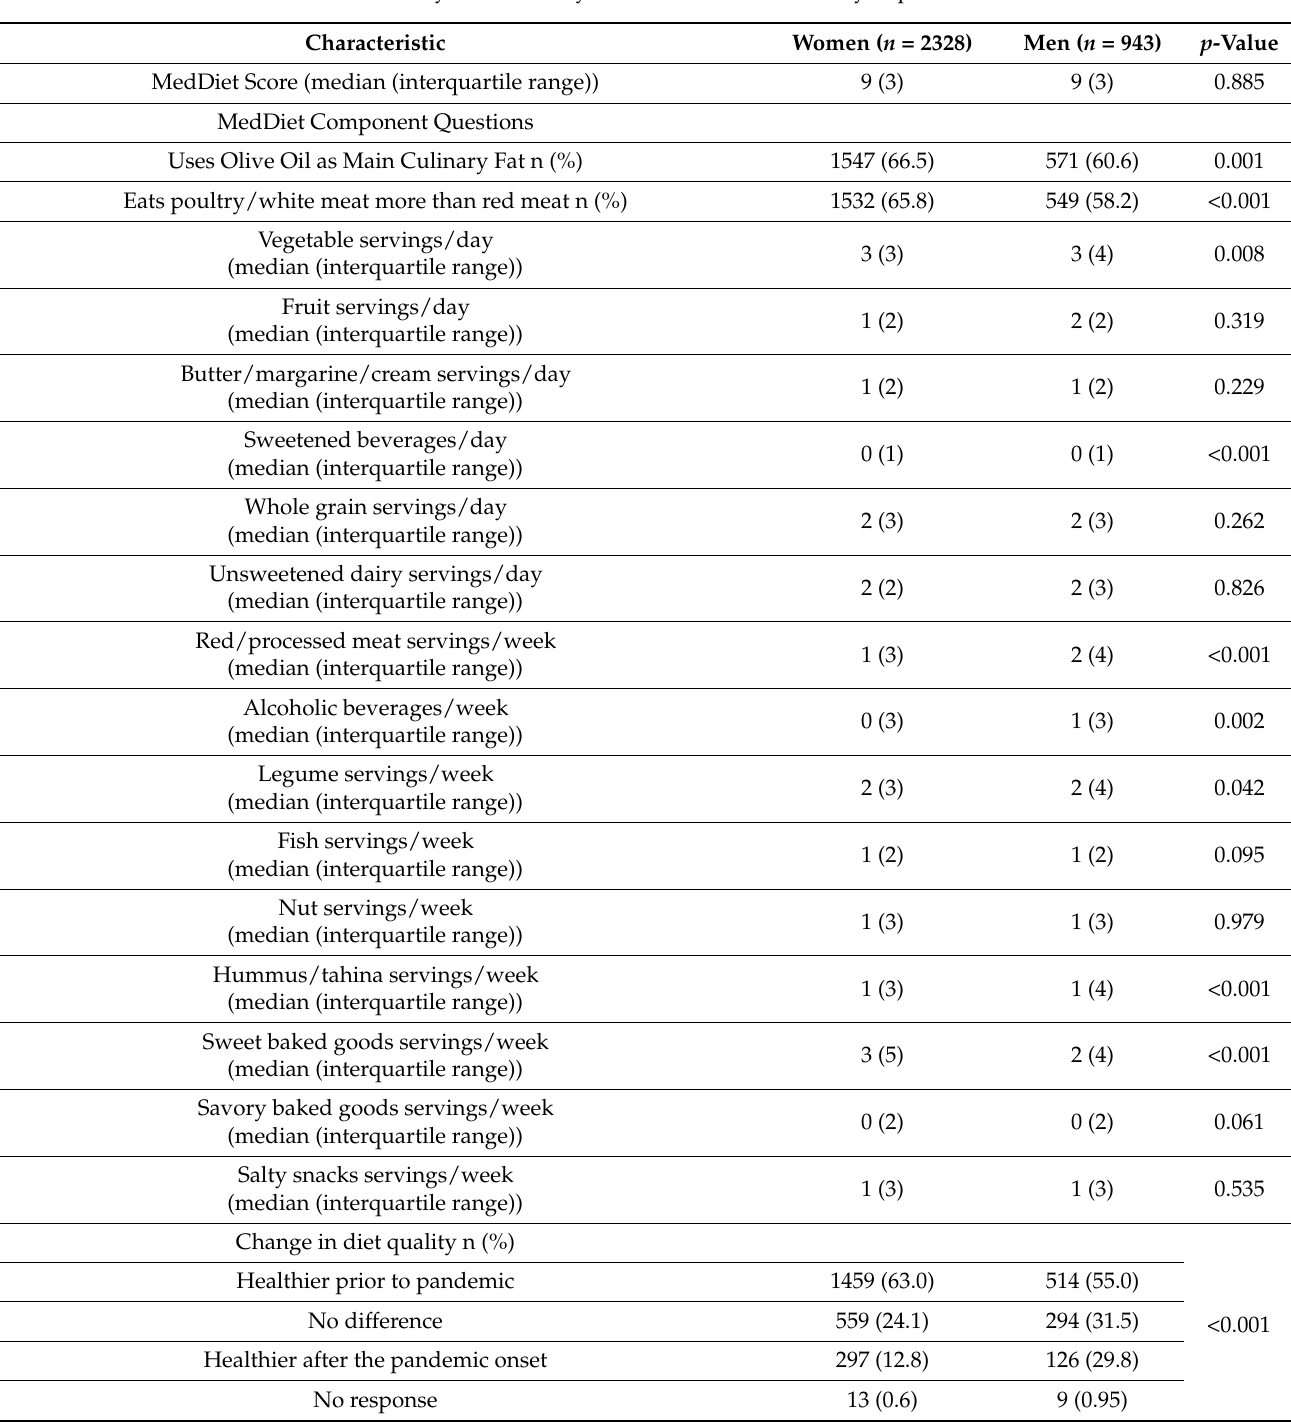
Table 2. Lifestyle and Dietary Characteristics of the Study